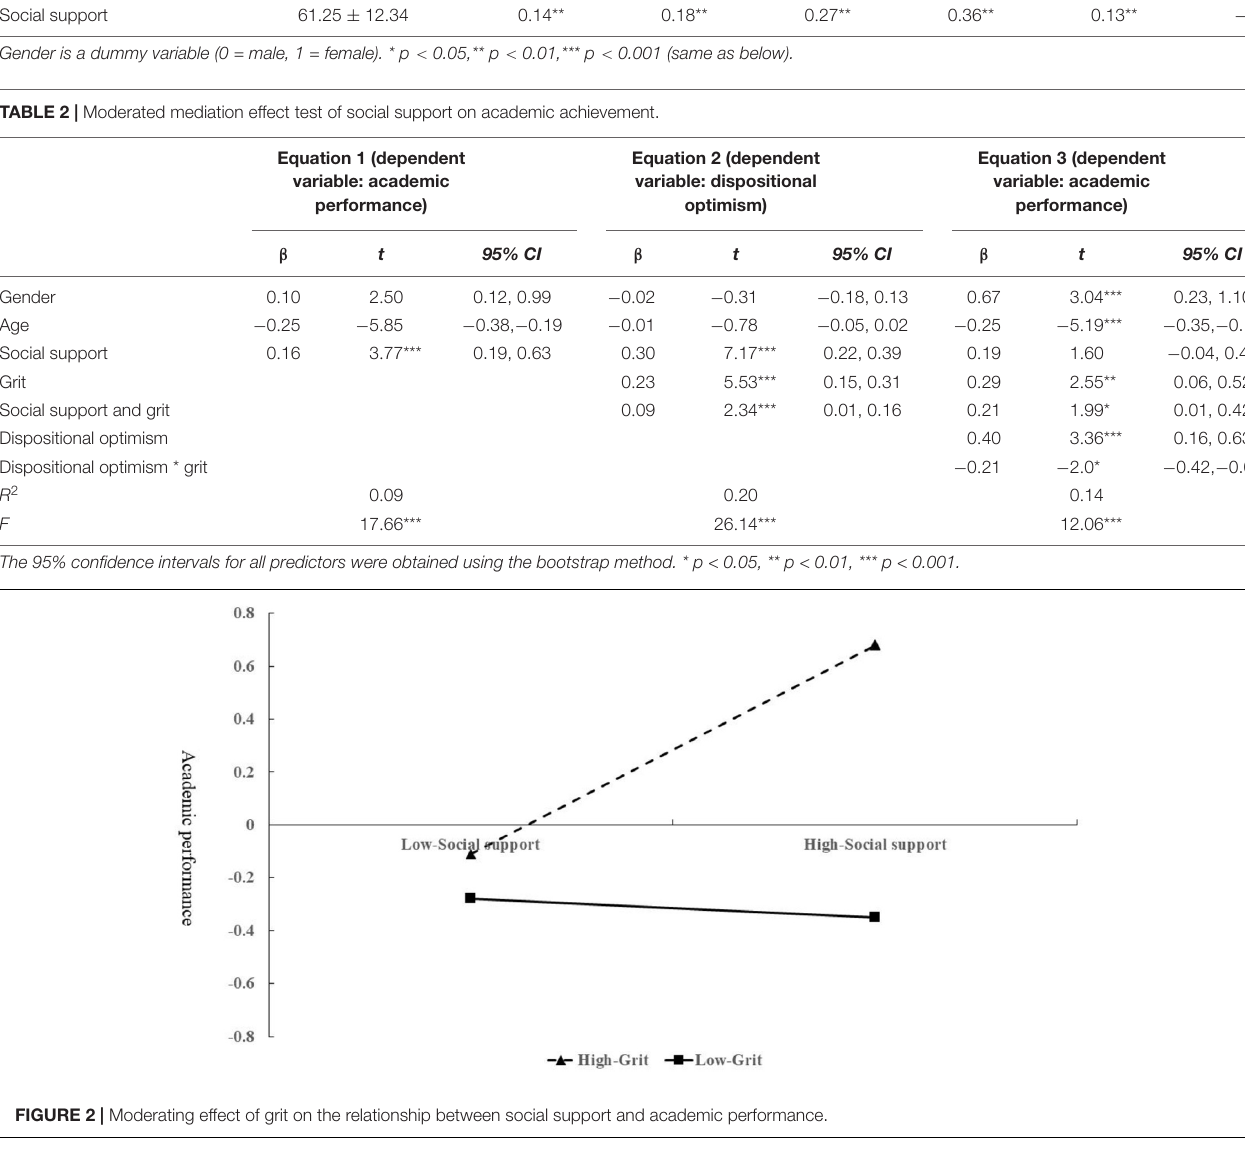
TABLE 2 | Moderated mediation effect test of social support on academic achievement.